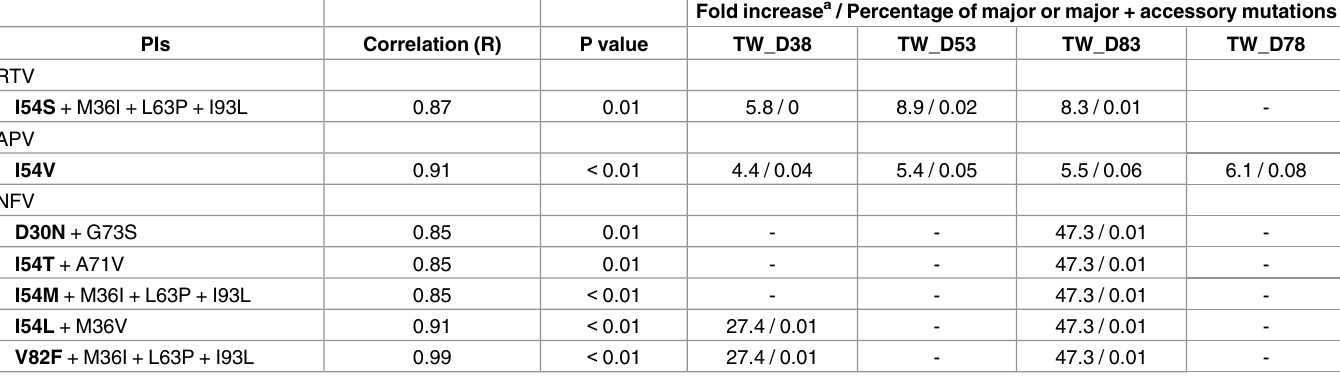
Bold indicates PI major drug resistance